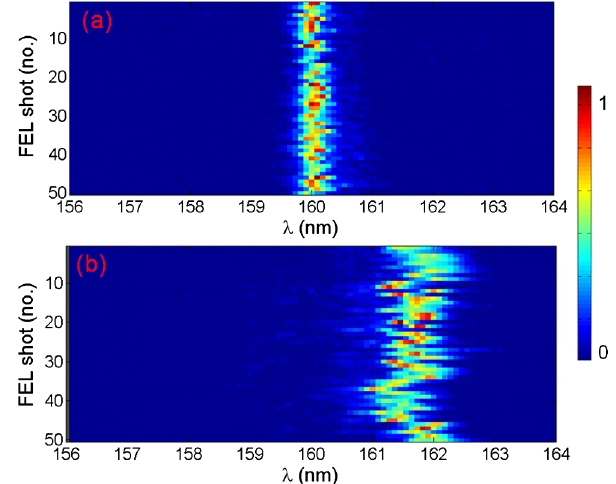
FIG. 7. Fifty consecutive radiation spectra for EEHG (a) and HGHG (b) with a chirped beam. Note, the central wavelength of HGHG signal is shifted by the linear chirp and the bandwidth of the HGHG signal is increased by the nonlinear chirp, while those for EEHG are essentially